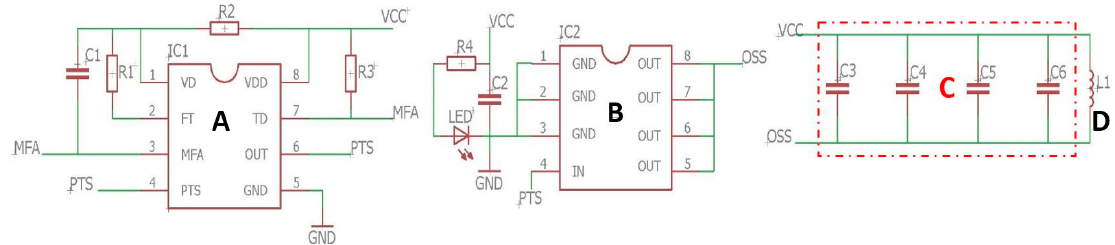
Figure 11. The wireless power transmitter apparatus core. Part A is a DC–DC converter and high frequency generator, part B is a power amplifier, part C is an oscillator, and part D is transmitter coil. (Where DC stands for direct current).